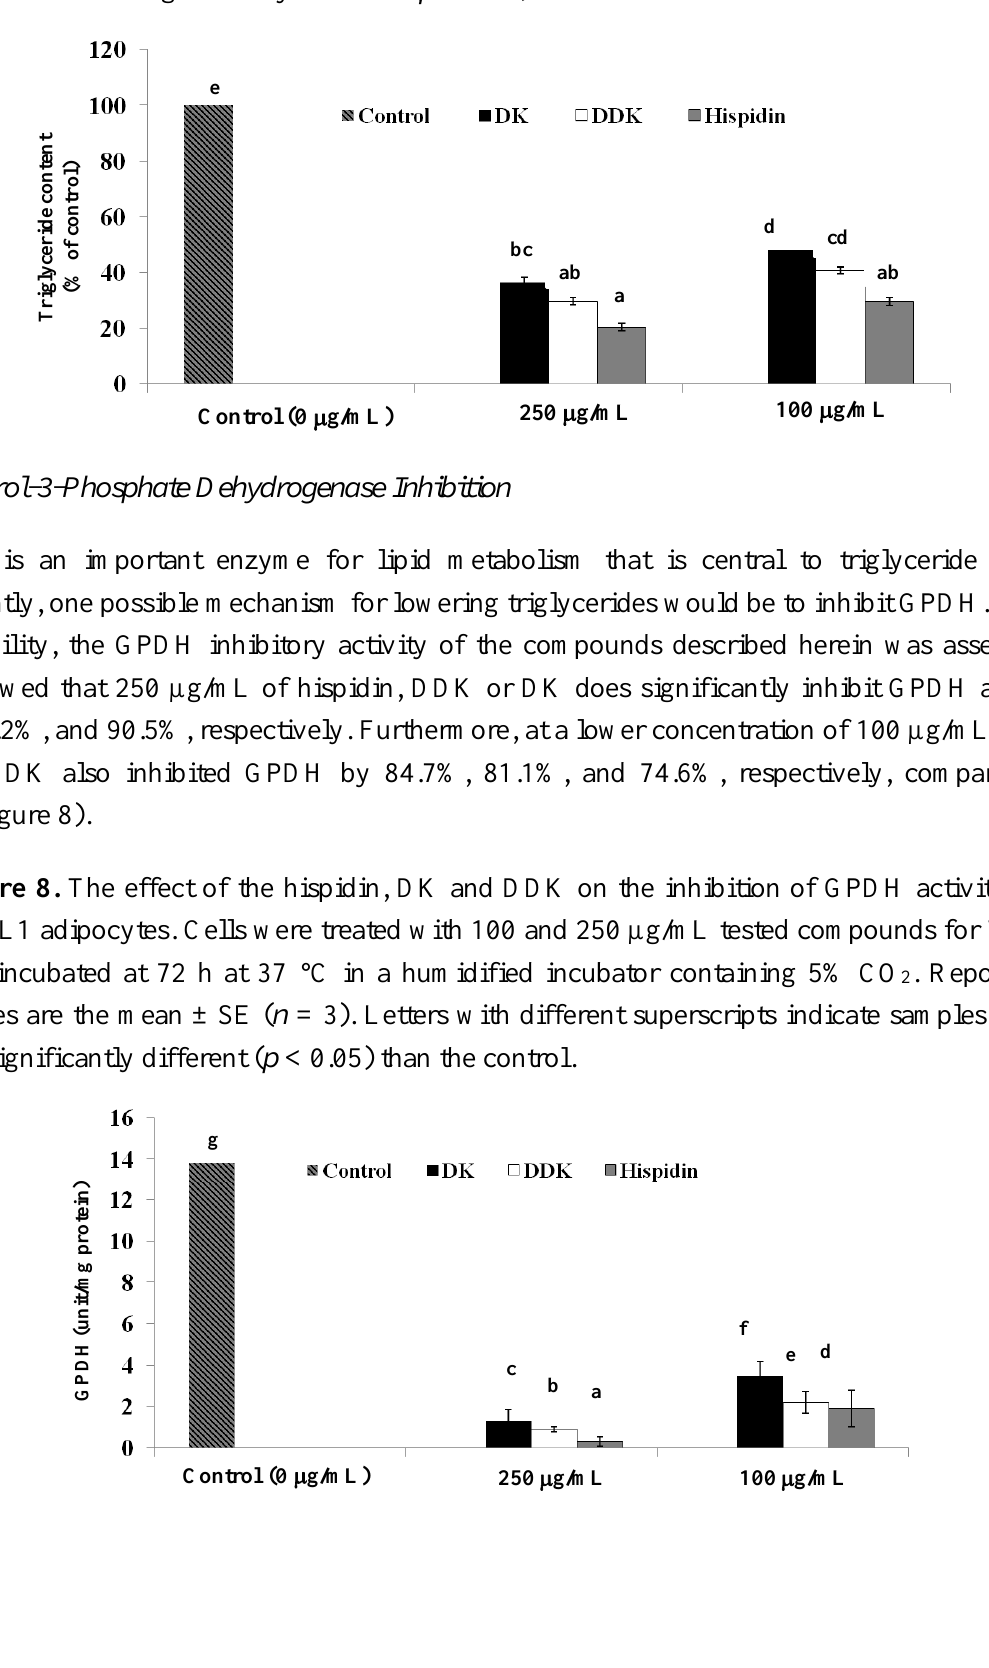
Figure 7. The effect of hispidin, DK and DDK on the inhibition of intracellular triglyceride content in 3T3-L1 adipocytes. Cells were treated with 100 and 250 µg/mL tested compounds for 72 h at 37 °C in a humidified incubator containing 5% CO 2 . Reported values are the mean ± SE ( n = 3). Letters with different superscripts indicate samples that are significantly different ( p < 0.05) than the control.